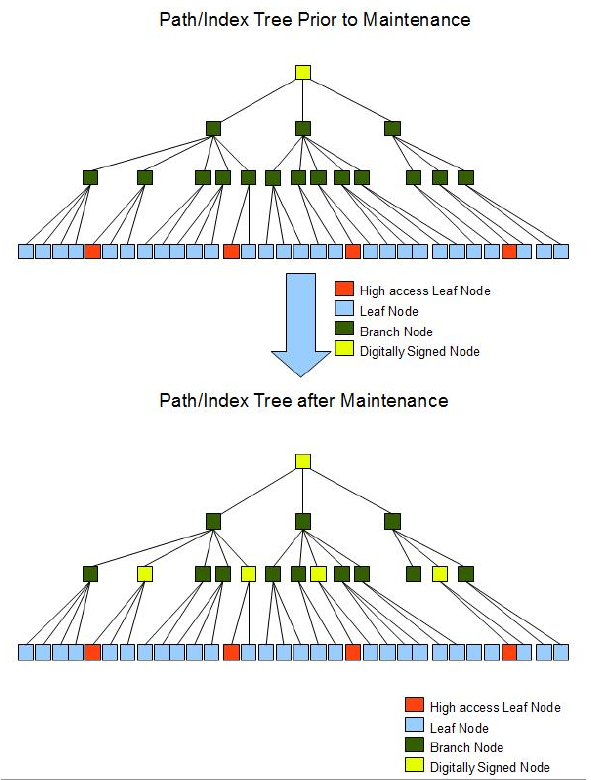
Fig. 4. Pre and Post Maintenance Tree Structure